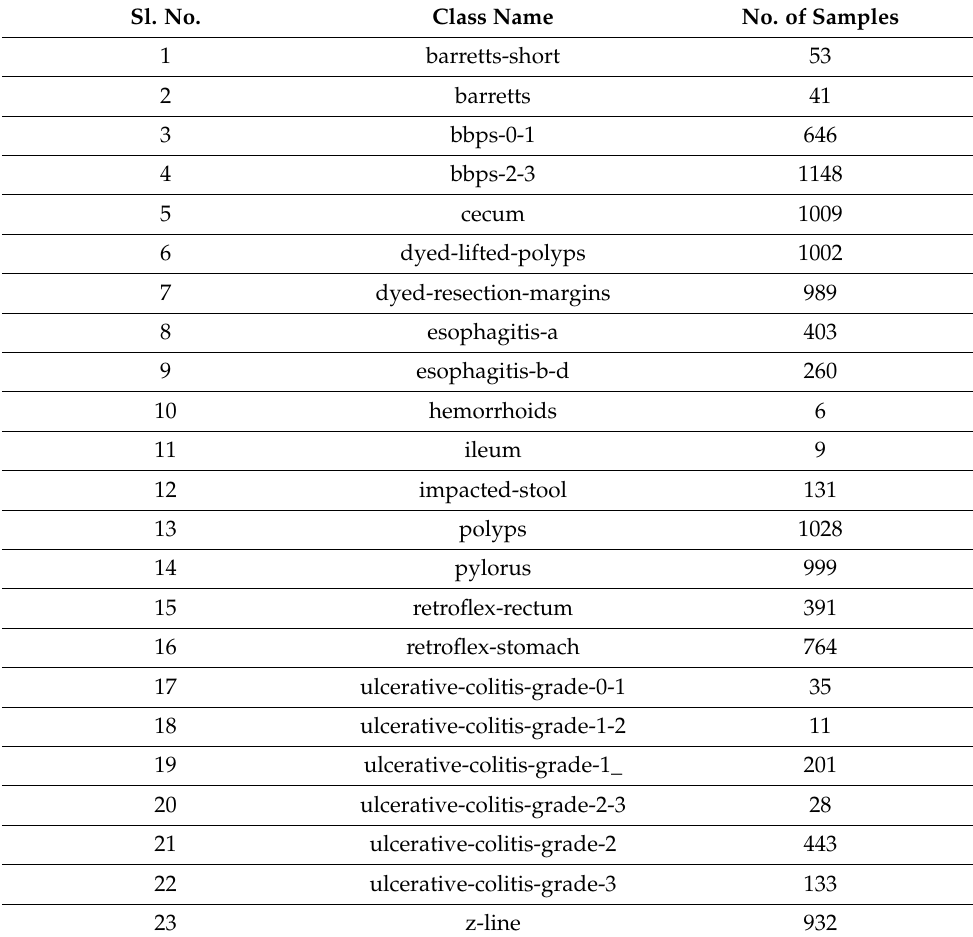
Table 1. Distribution of samples for 23 gastrointestinal diseases. Sl. No.